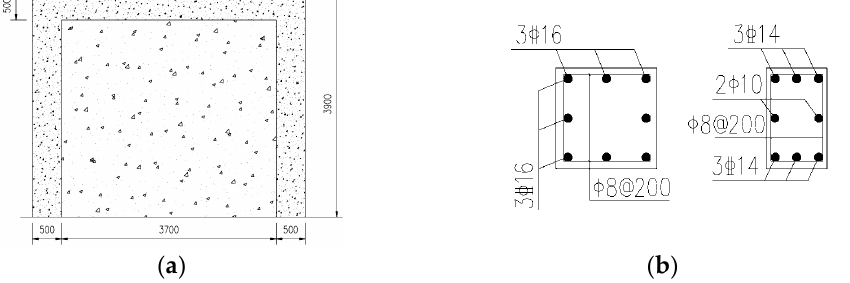
Figure 3. The related design diagrams of GJ-2. ( a ) Energy-dissipated low-rise concrete shear wall with CFST short columns; ( b ) reinforcement diagram of the beam and column of the shear wall.